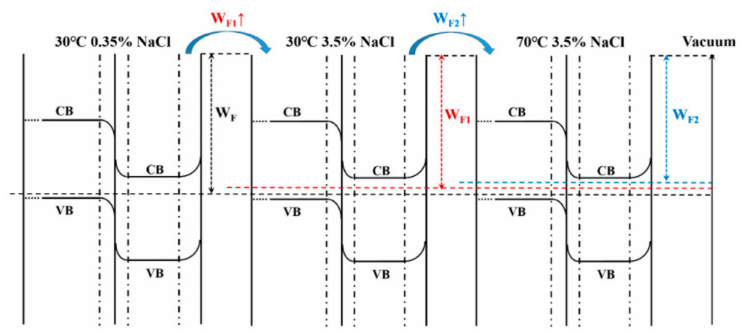
Figure 11. Schematic diagram of the changes in electronic work function ( W F ) of passive films formed on Fe-based AMCs in NaCl solutions with various concentration and